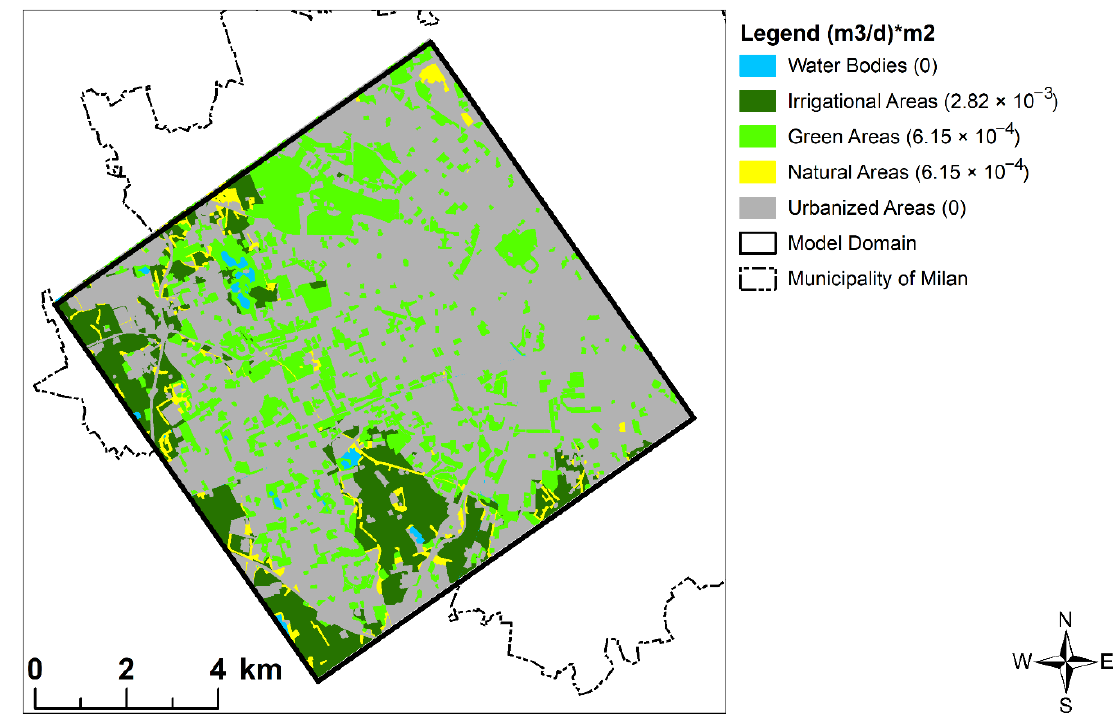
most well field) of the initial value.